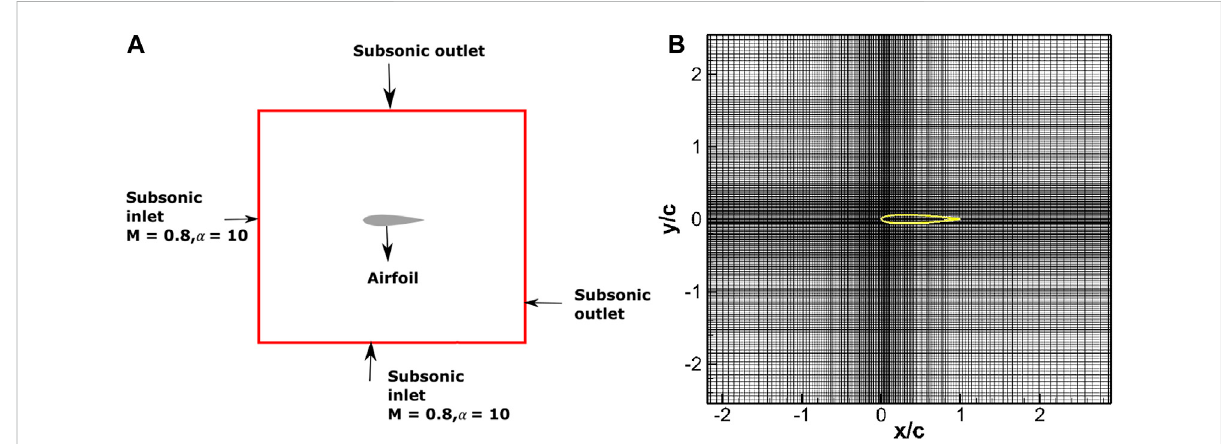
FIGURE 15 Schematic representation of the domain with boundary conditions indicated: fl ow past airfoil NACA0012 (A) and close-up view of the 648 × 1,024 non-uniform mesh (B) (showing alternate grid lines in both directions); IB shown by the yellow